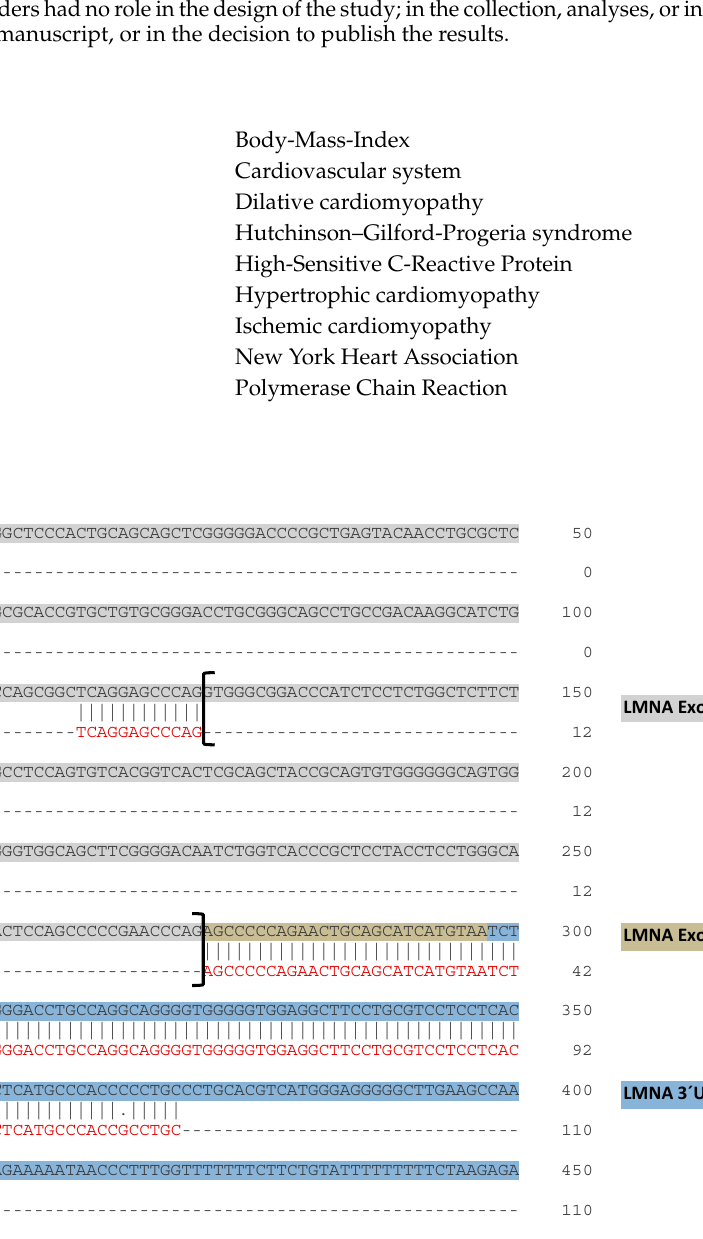
Figure A1. Sequencing of progerin PCR product cDNA confirms alternative splicing in the blood. Sequence alignment of purified progerin PCR cDNA (red letters) with the genomic sequence of LMNA between exon 11 (grey) to exon 12 (green) with the 3´UTR sequence (blue) revealed the anticipated gap of 150bp between exon 11 to exon 12 confirming alternative splicing of progerin. Table A1. Diagnosis of included patients.